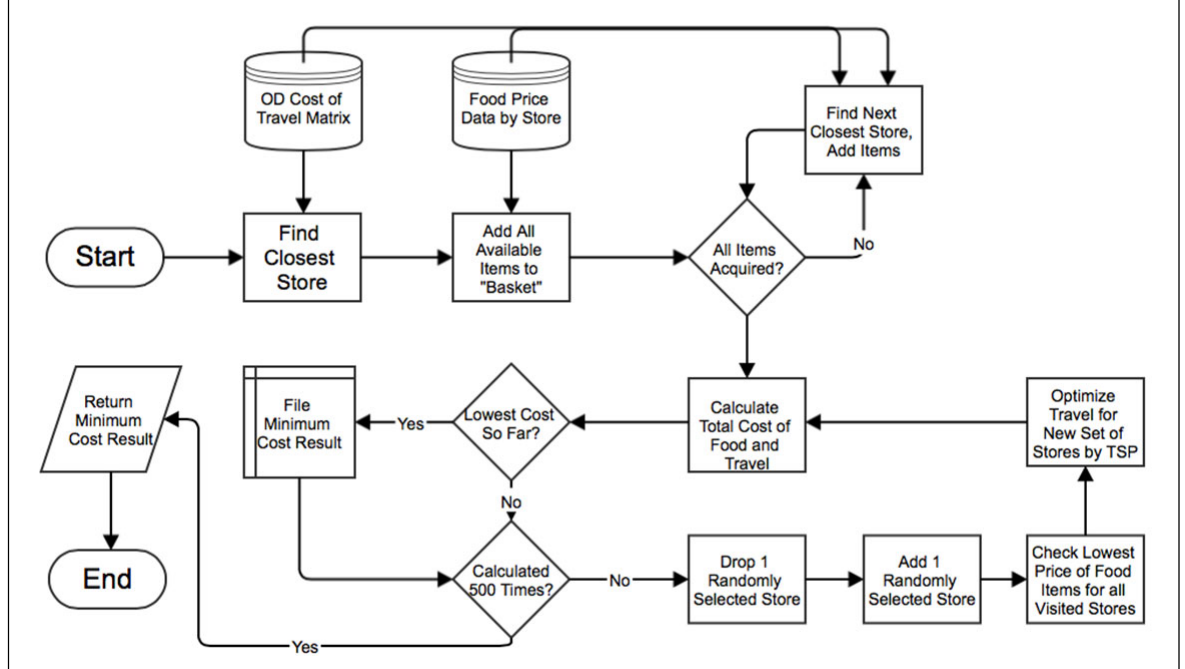
Figure 1. Flow chart for the algorithm used to determine the lowest-cost combination of travel and food item cost to purchase all items in the USDA Thrifty Food Plan for each residential parcel in the study